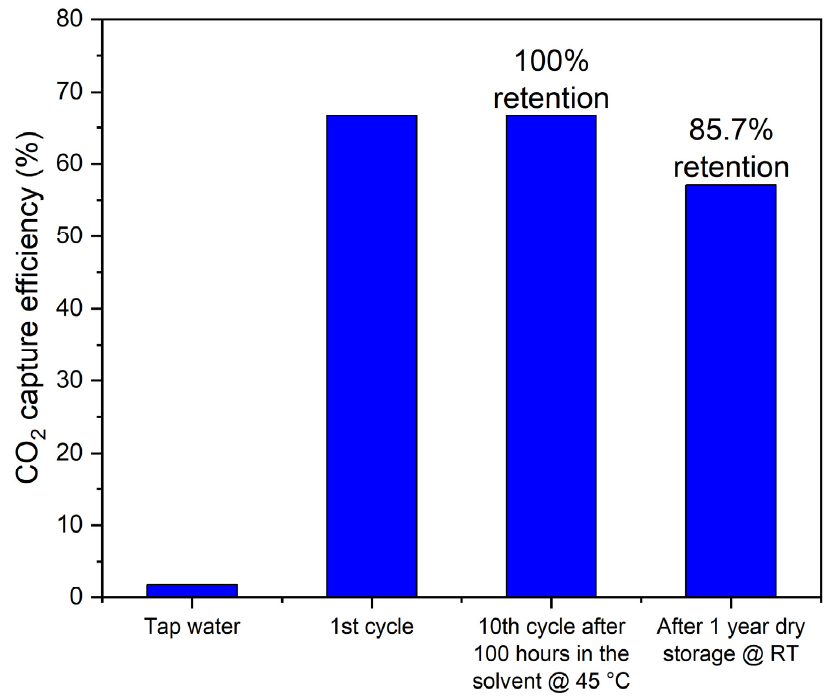
Figure 7. Reusability of surface-only covalent 3-D aggregate immobilized enzyme packing.